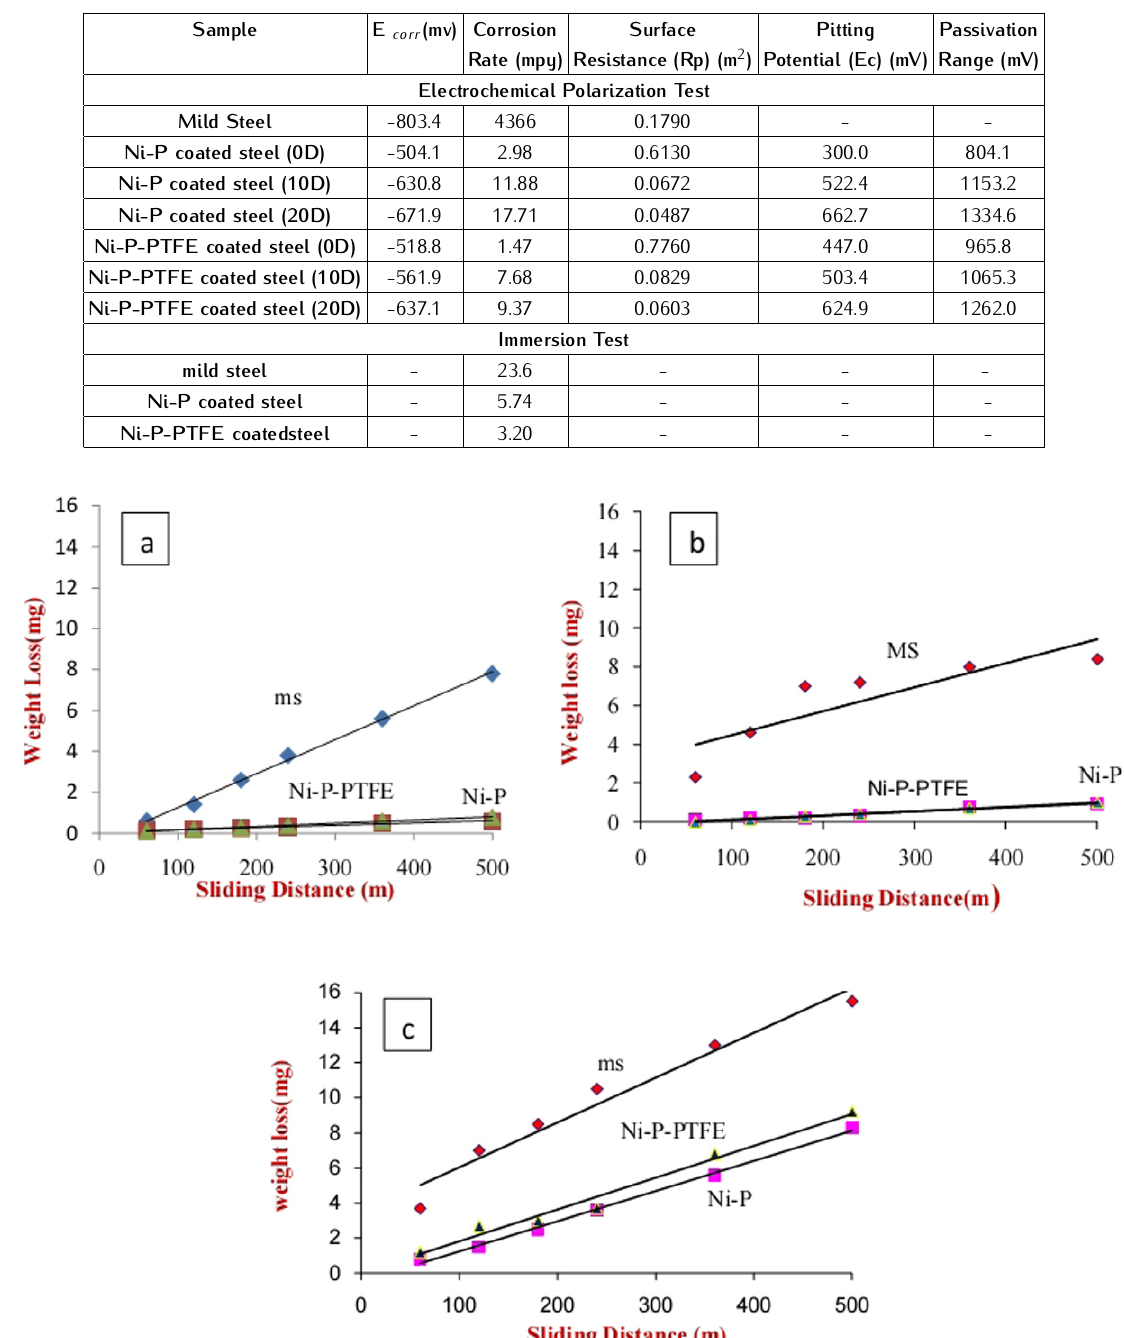
Figure 8. Weight loss vs. sliding distance graphs for mild steel (ms) substrates, Ni-P and Ni-P-PTFE nanocomposite coatings (a) under 10 N (b) 20 N(c), and 30 N loads.